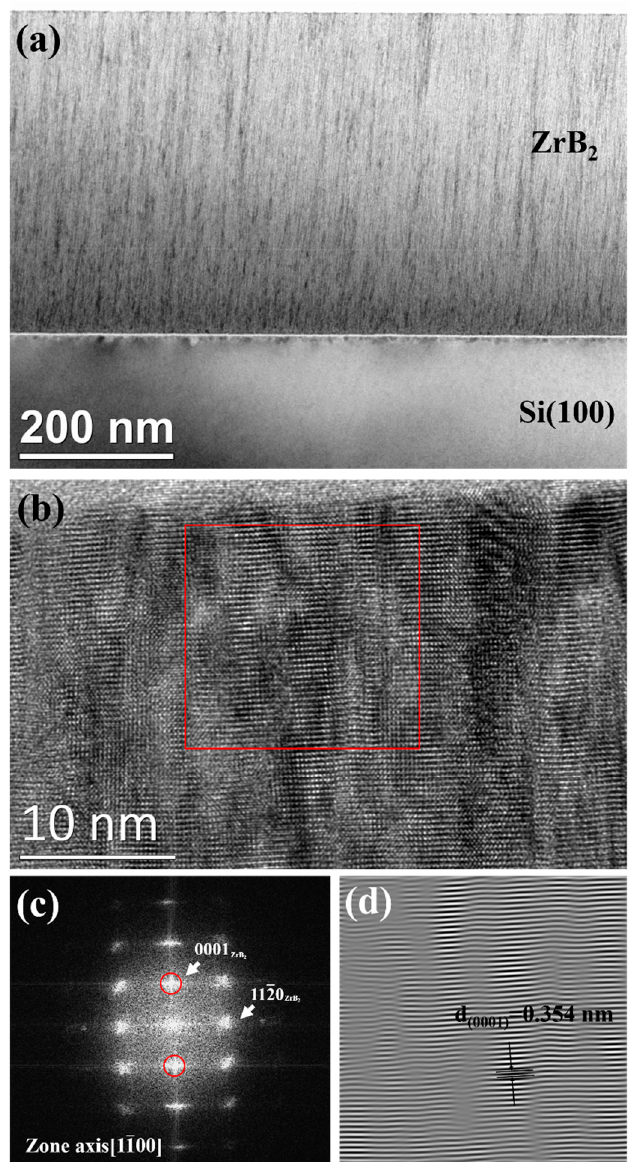
Figure 3. ZrB 2 film was annealed at 870 °C ( a ) The cross-sectional TEM image and ( b ) HR-XTEM image of ZrB 2 film. ( c ) the FFT pattern of the framed region in ( b ) red square. ( d ) Fourier-filtered image of the framed region in ( c ), obtained by selecting ±(0001) ZrB 2 and ±(11–20) ZrB 2 spots.